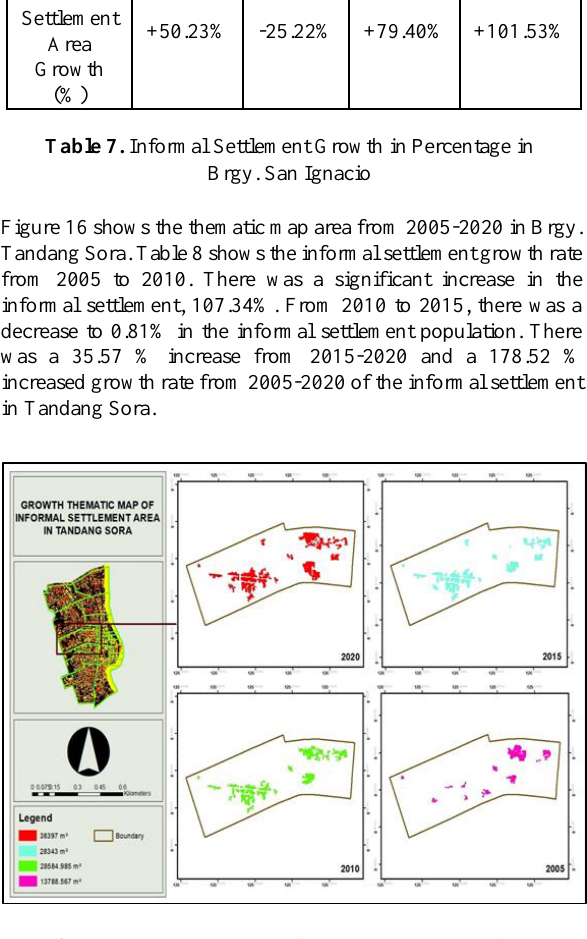
Figure 16. Thematic Map of Brgy. Tandang Sora from